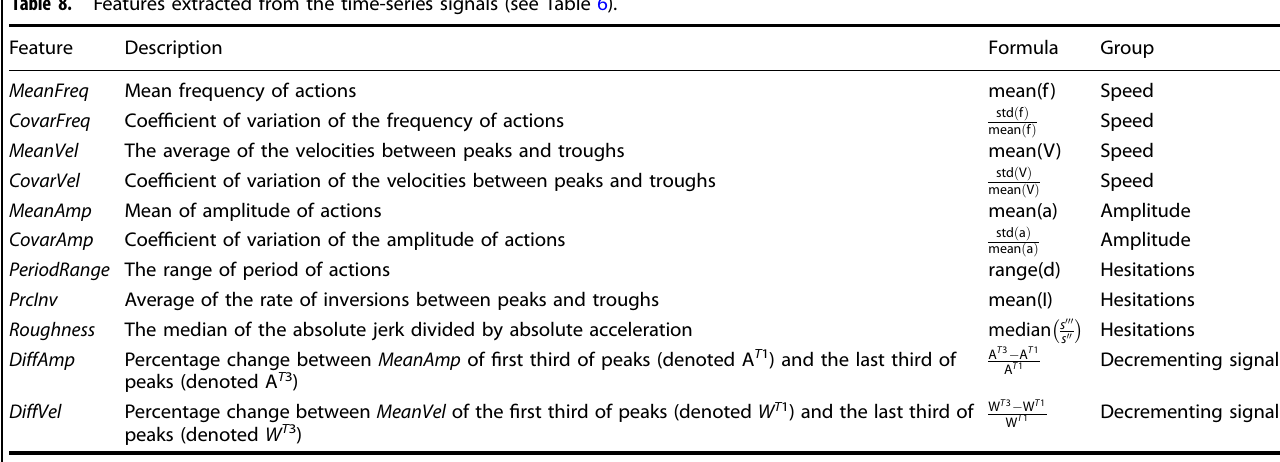
The same 11 features were used for each bradykinesia classi fi cation